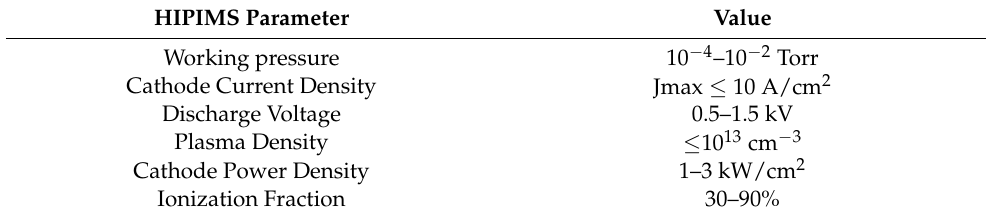
Table 2. Working parameters for HIPIMS technology.